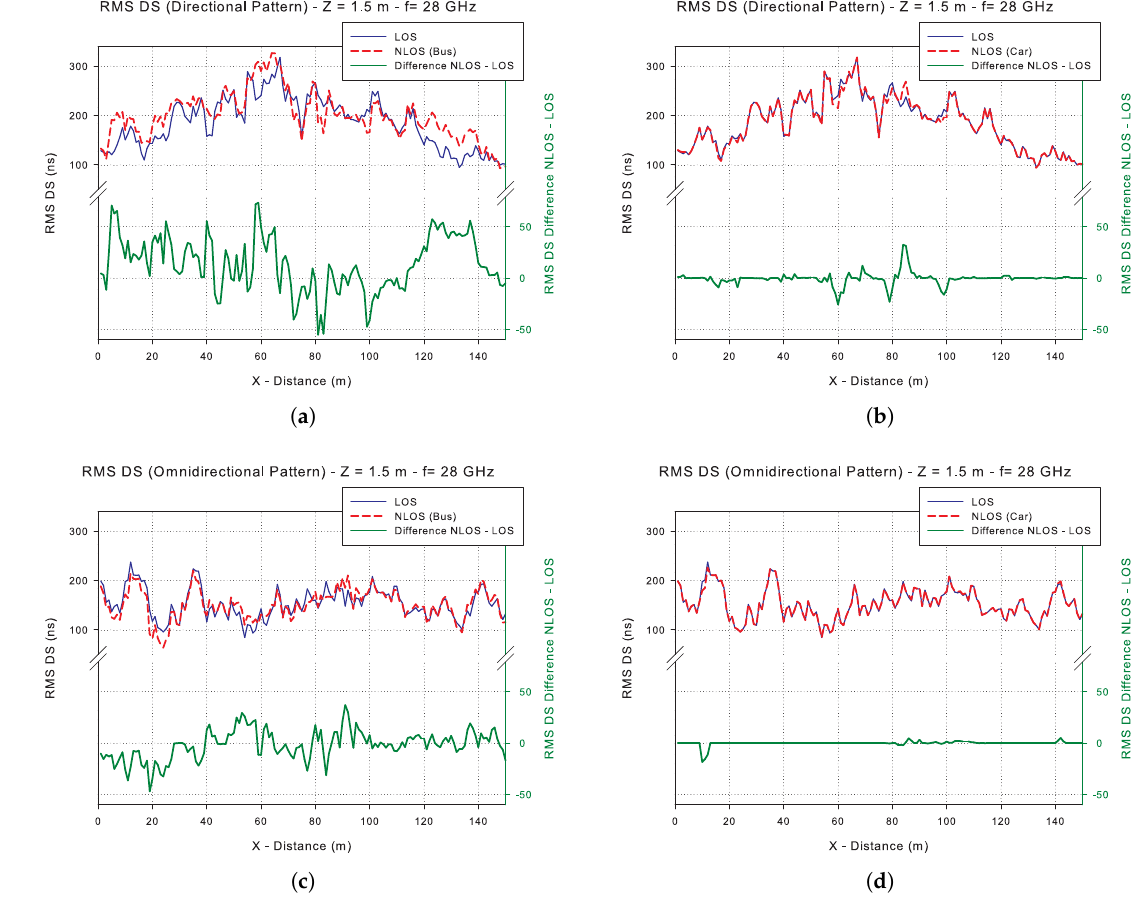
Figure 15. RMS DS simulation results for a radial R2 in the receiver trajectory: ( a ) Directional radiation antenna pattern and bus obstruction, ( b ) Directional radiation antenna pattern and car obstruction, ( c ) Omnidirectional radiation antenna pattern and bus obstruction, ( d ) Omnidirectional radiation antenna pattern and car